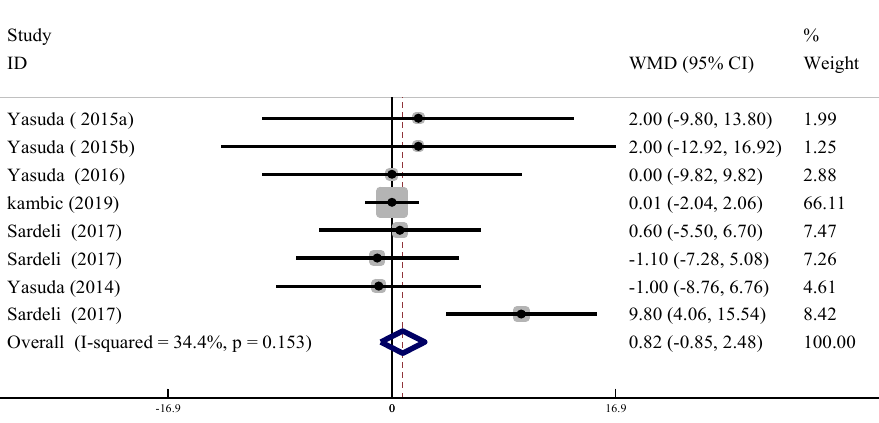
Figure 7. Forest plot of the effect of LL-BFR training on resting heart rate.